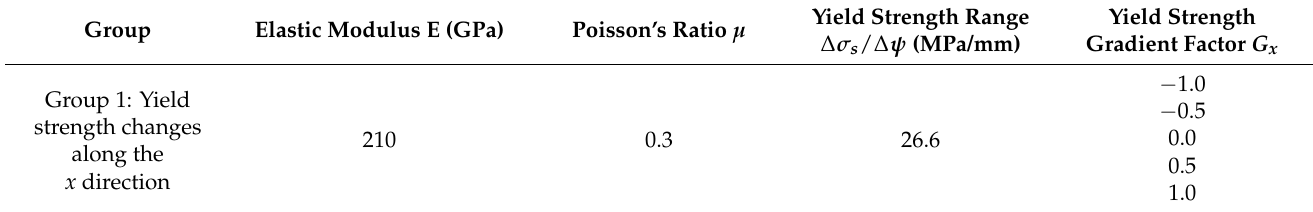
Table 1. Yield strength changes along the x -direction elastoplastic material field.